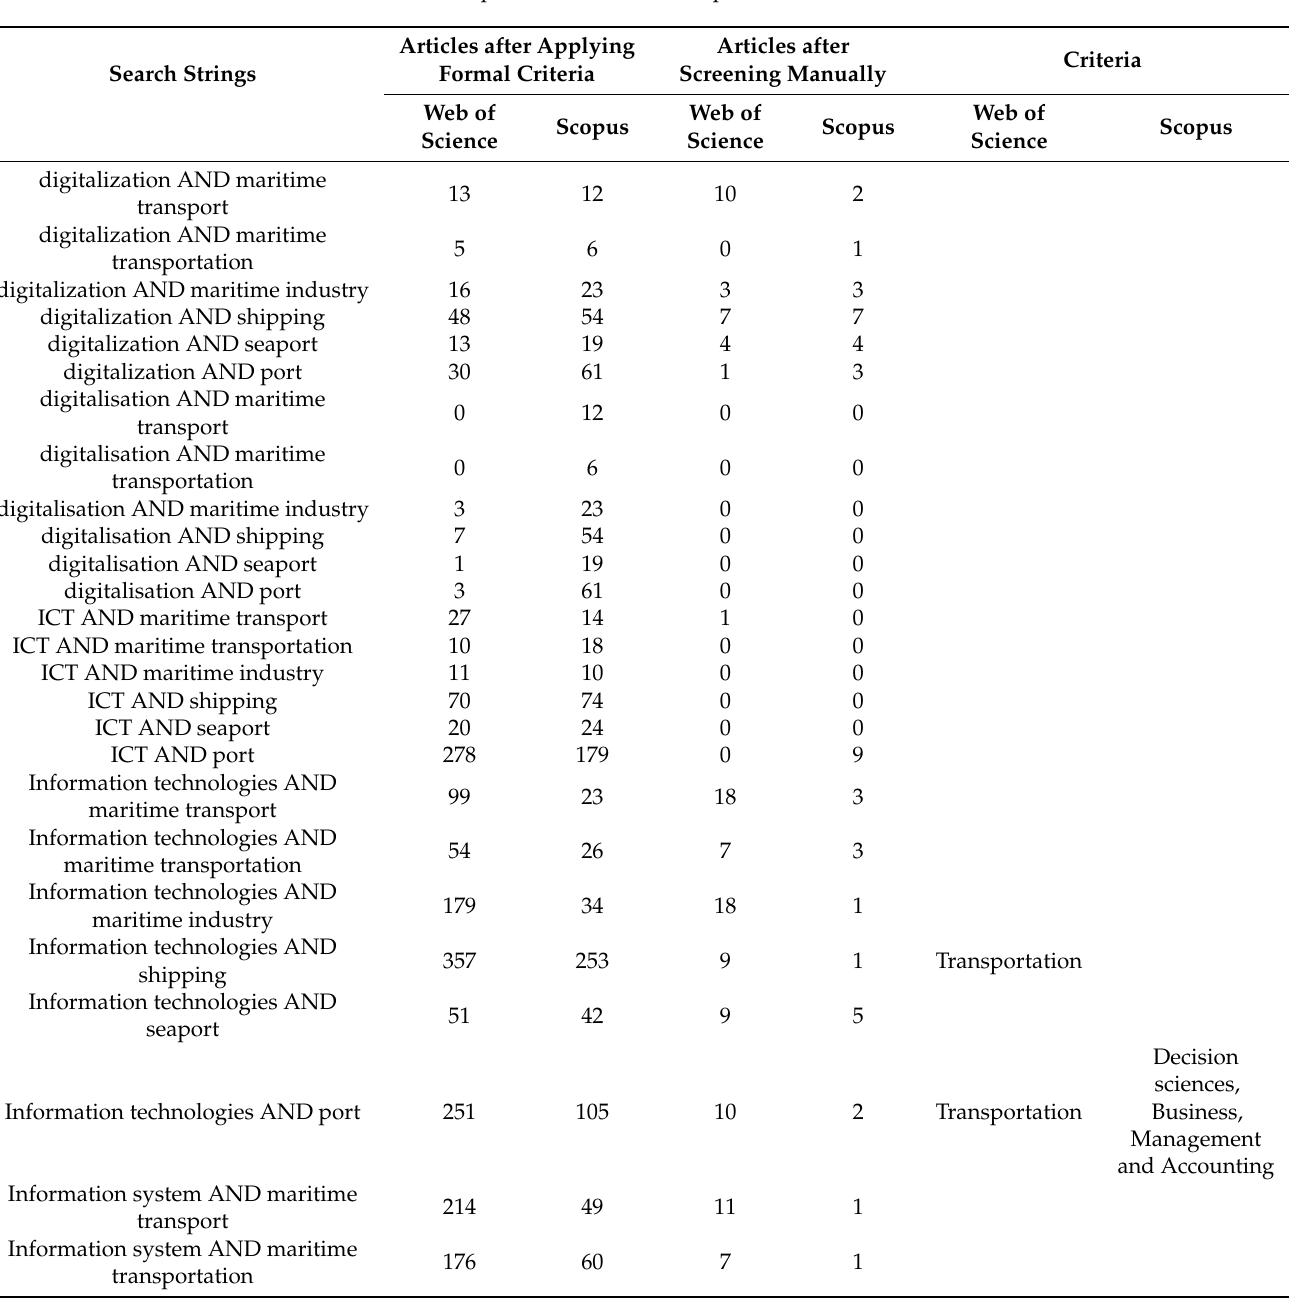
Table A1. Search process in WoS and Scopus